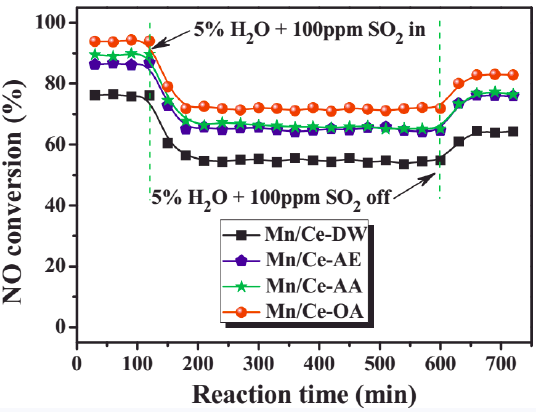
Figure 6. The effect of H 2 O and SO 2 on NO conversion for Mn/CeO 2 catalysts (Reaction conditions: [NO] = [NH 3 ] = 500 ppm, [O 2 ] = 5 vol%, [SO 2 ]=100 ppm, [H 2 O] = 5 vol %N 2 balance, T = 200 °C, 60,000 mL g − 1 h − 1 ). (Reproduced with permission from Reference [26], Copyright 2017, Elsevier.).